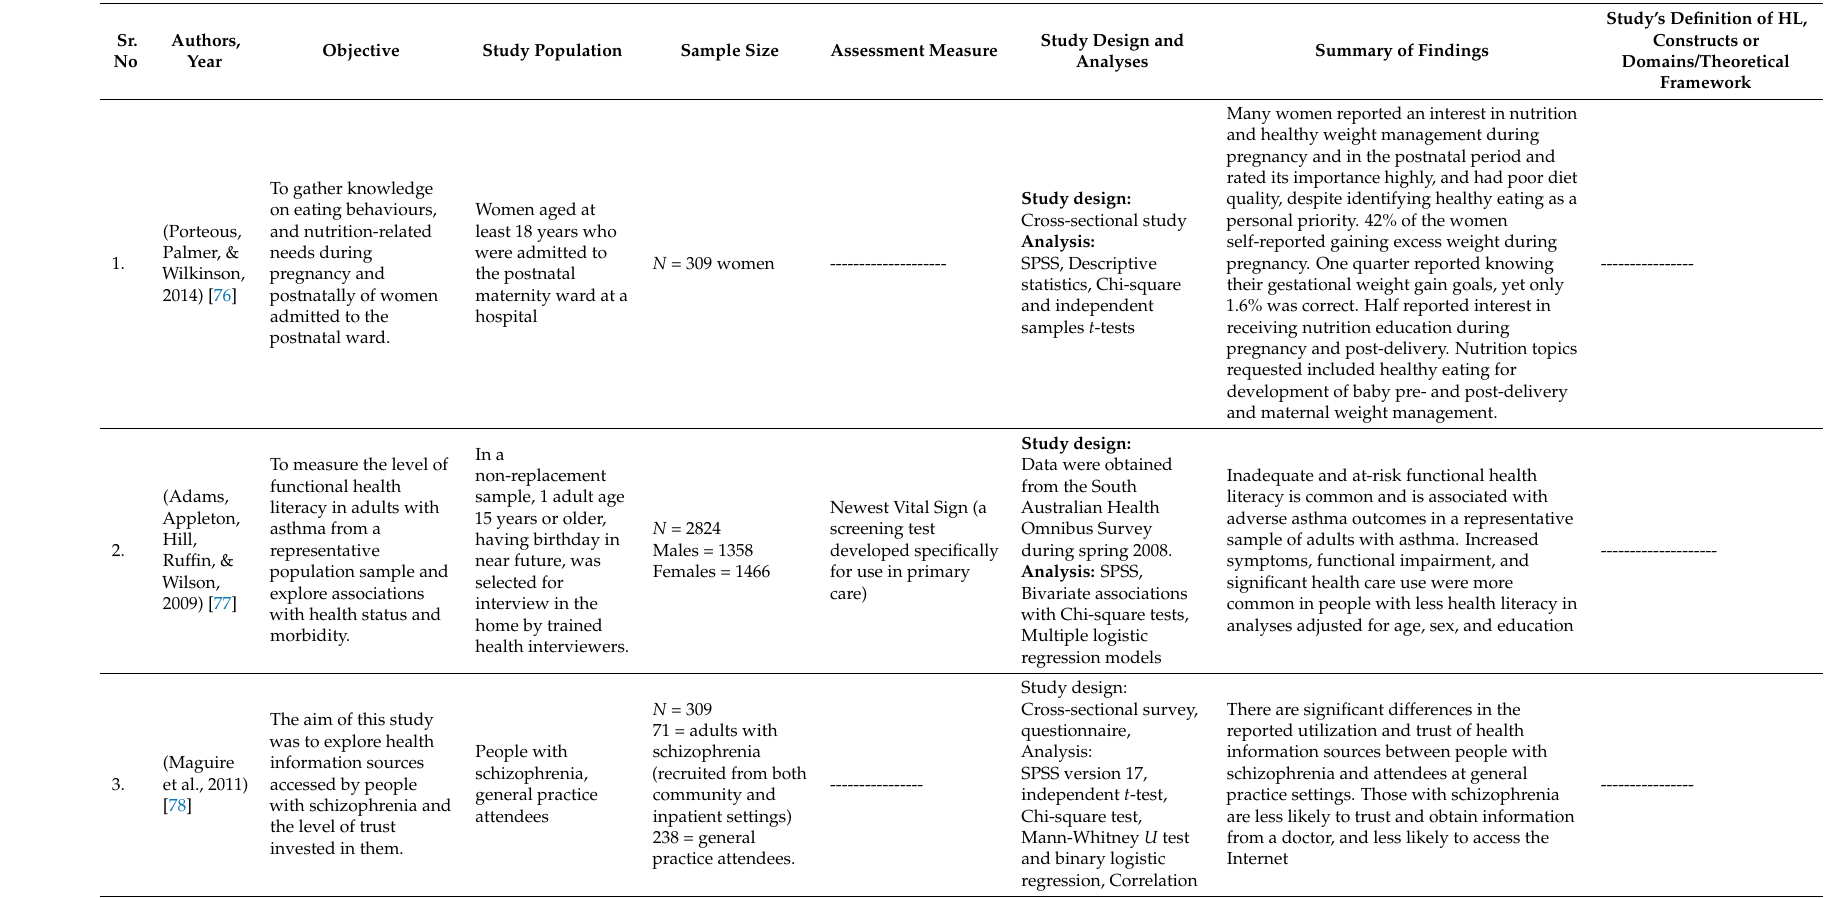
Table 3. Characteristics of the selected